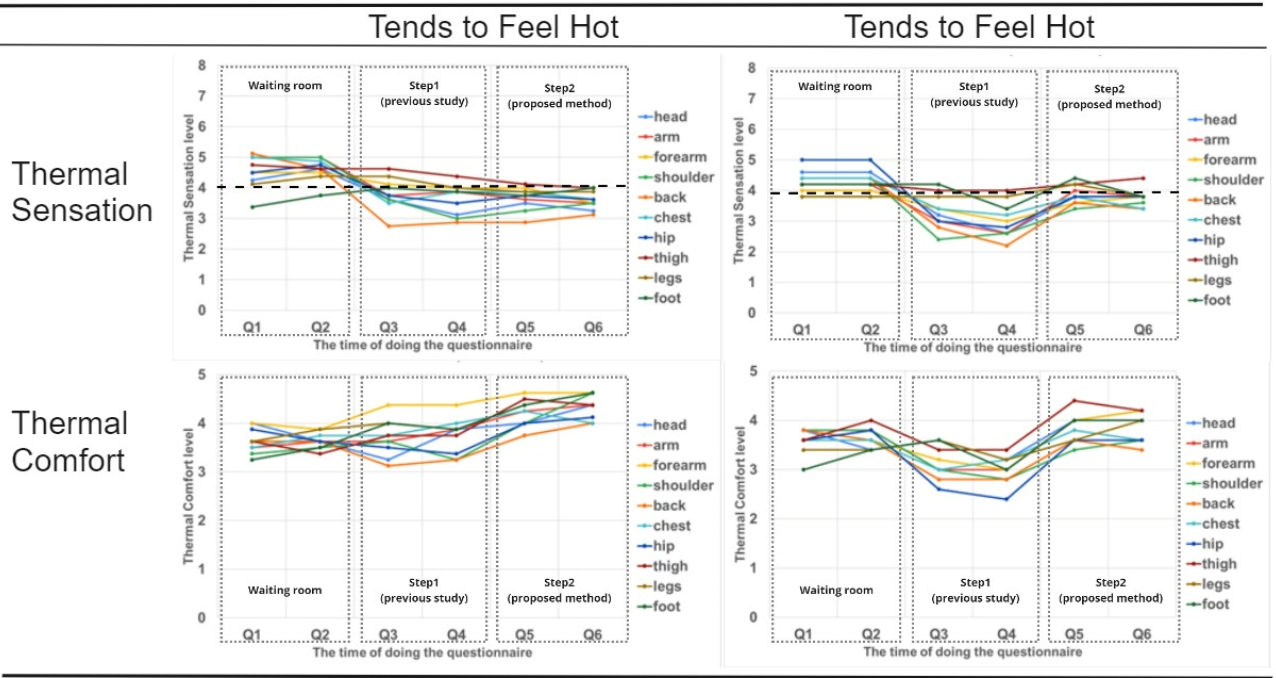
Figure 13. Comparison of thermal sensation and thermal comfort, and tendency to feel hot and cold.